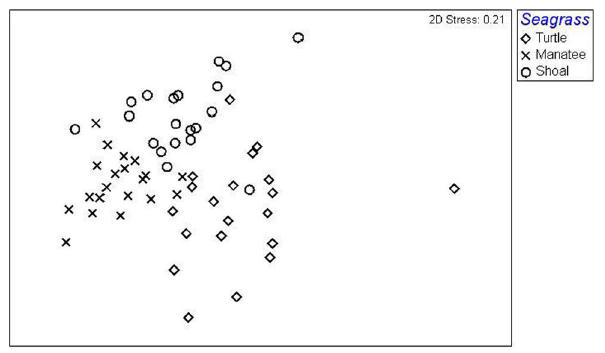
(Table 5). Tukey’s HSD test indicated that biodiversity (F 15,59 = 4.10, p , 0.05) and density of red drum (F 15,59 =11.10, p , .001) were higher on the last sampling date than the other three sampling dates. Density of pipefish and seahorses were higher on